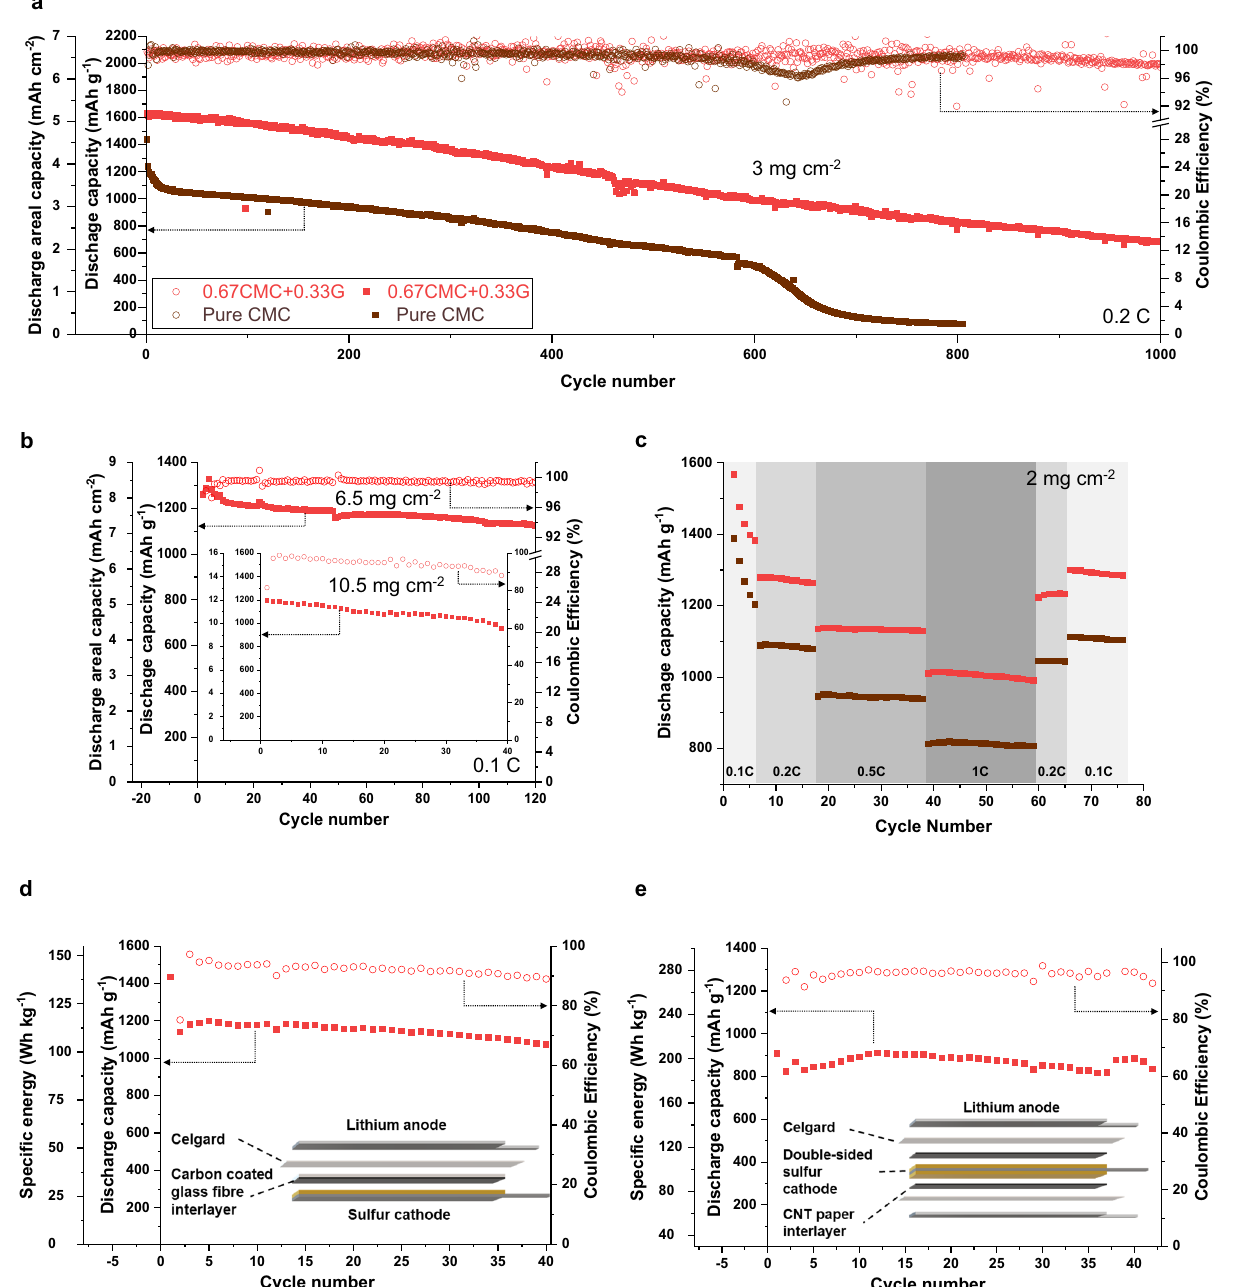
Fig. 6 Cycling performance comparison between CMC cathode and CMC/G cathode. Coin cells con fi gured with a 3 mg cm − 2 sulfur loading cathode, b 6.5 mg cm − 2 sulfur loading cathode and 10.5 mg cm − 2 sulfur loading cathode shown in the insert plot. c Rate capability data among two compared coin cells (2 mg cm − 2 sulfur loading). Red lines indicate the performance of CMC/G cathode, and the brown lines indicate the performance of CMC cathode. Con fi guration of the pouch cell with d single-sided cathodes e double-sided cathodes with lean electrolyte condition (E/S = 6 μ L mg − 1 ), optimised for speci fi c energy. 1 C-rate is equivalent to 1 h charge or discharge a battery. To convert C-rate to current density, current density (mA cm − 2 ) = sulfur loading (g cm − 2 ) × Li-S theoretical capacity (1675 mAh g − 1 ) ×